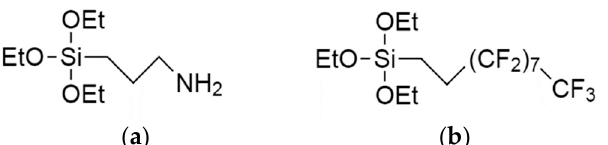
Figure 1. Molecular structure of ( a ) 3-aminopropyl-triethoxy-silane (APTS) and ( b ) 1 H ,1 H ,2 H ,2 H - perfluorodecyl-triethoxy-silane (PFDS).